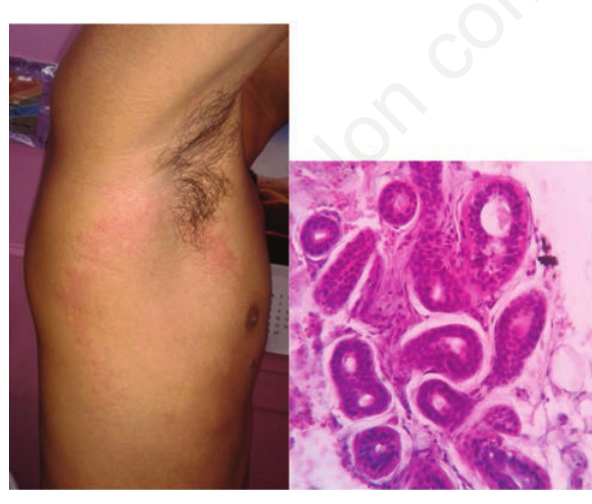
Figure 3. A) The rash in symmetrical periflexural exanthem, also known as unilateral laterothoracic exanthem, commences on the